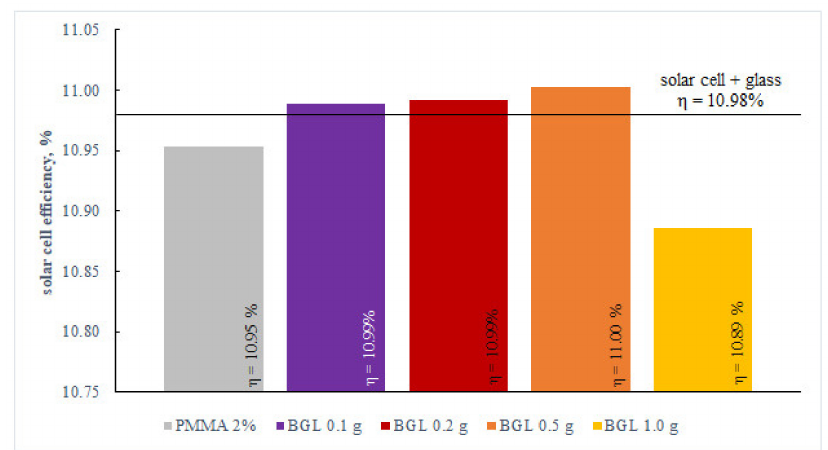
Figure 8. The efficiency comparison of BGL pigment in isopropanol